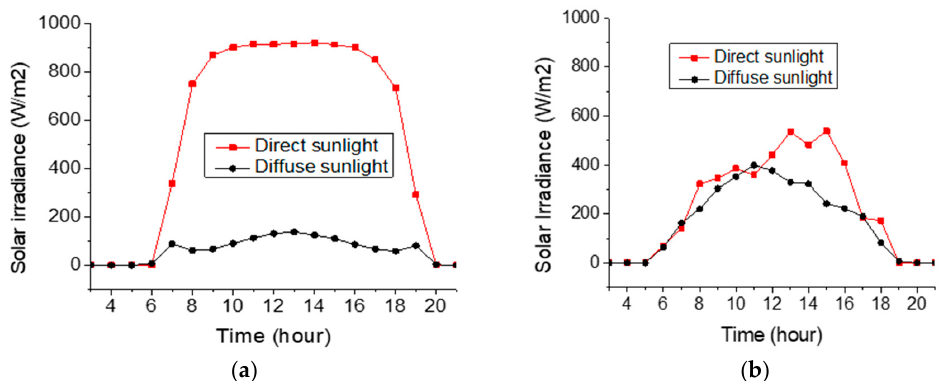
Figure 7. Solar irradiance during a day in ( a ) Phoenix (USA) and ( b ) Seoul (Korea) for simulation.